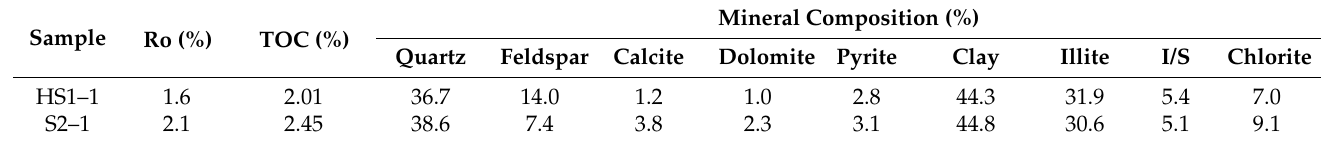
Table 1. Basic geochemical parameters of the studied